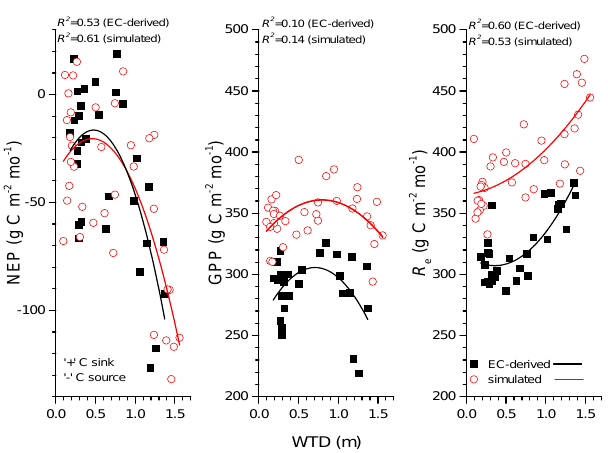
Fig. 10. Five-day moving averages of simulated daily net ecosys- tem productivity (NEP) for drained vs. undrained simulations (Sect. 2.2.6) during 2002–2005 over a drainage affected tropical peat swamp forest at Palangkaraya, Indonesia. Drained values are the same as those in Figs.